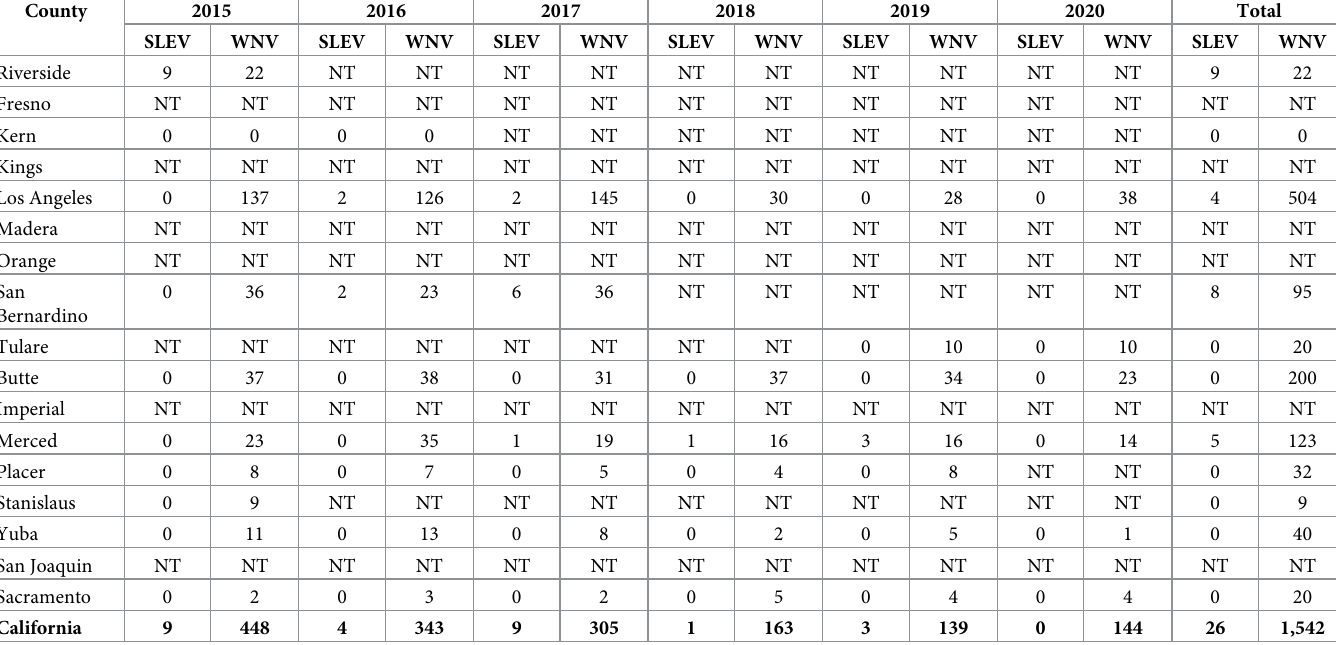
Table 2. Number of sentinel chicken seroconversions for St. Louis encephalitis virus (SLEV) and West Nile virus (WNV) in California counties where SLEV was detected, 2015–2020. NT = no flocks deployed or tested. County